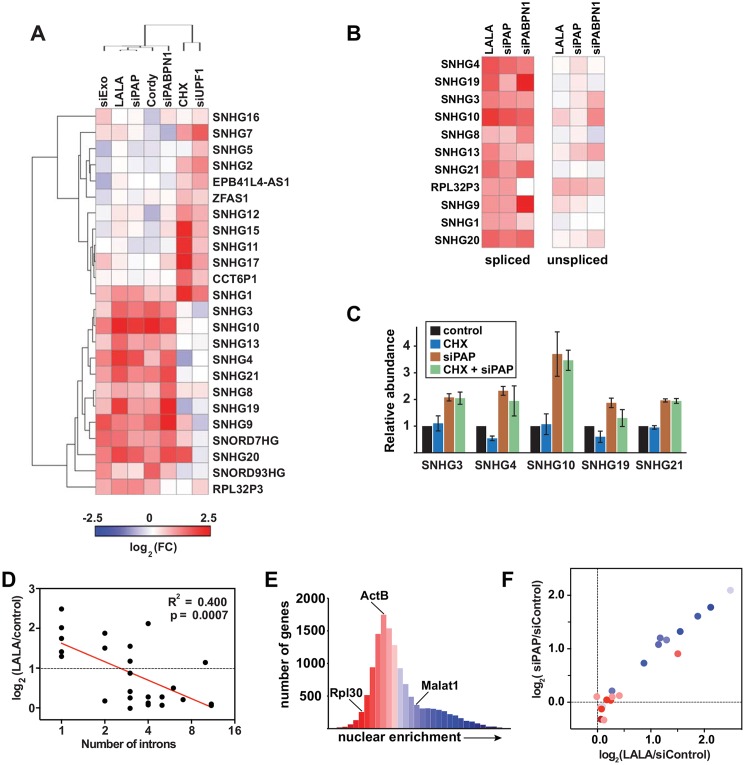
NcSNHGs are degraded by PPD or NMD.
(A) Heat map showing the changes in spliced ncSNHG levels following RRP6 and DIS3 knockdown (“siExo”), LALA expression, PAP knockdown, cordycepin treatment, PABPN1 knockdown, cycloheximide (CHX) treatment, or UPF1 knockdown. Log2 fold change (FC) values were determined by qRT-PCR (n = 3). 7SK RNA was used as a loading control for the cycloheximide experiment, while β-actin or GAPDH was used for all other samples. (B) Same as in (A), but the relative changes in spliced (left) and unspliced (right) transcripts are shown. The left panel is reproduced from (A). (C) Bar graphs of qRT-PCR data comparing the average relative levels of six ncSNHGs following cycloheximide, siPAP or both treatments. The error bars are standard deviation (n = 3). (D) Correlation between intron number and the fold change in transcript levels following LALA expression. Expression values are derived from the experiments in (A); the red line is a linear regression. (E) Nuclear enrichment scores calculated from each expressed gene (FPKM>0.5, n = 13,114) were placed into 32 bins and color-coded from red to blue. (F) Each ncSNHG was plotted by the average log2(FC) values from (A) and color-coded by its NES as determined in (F).